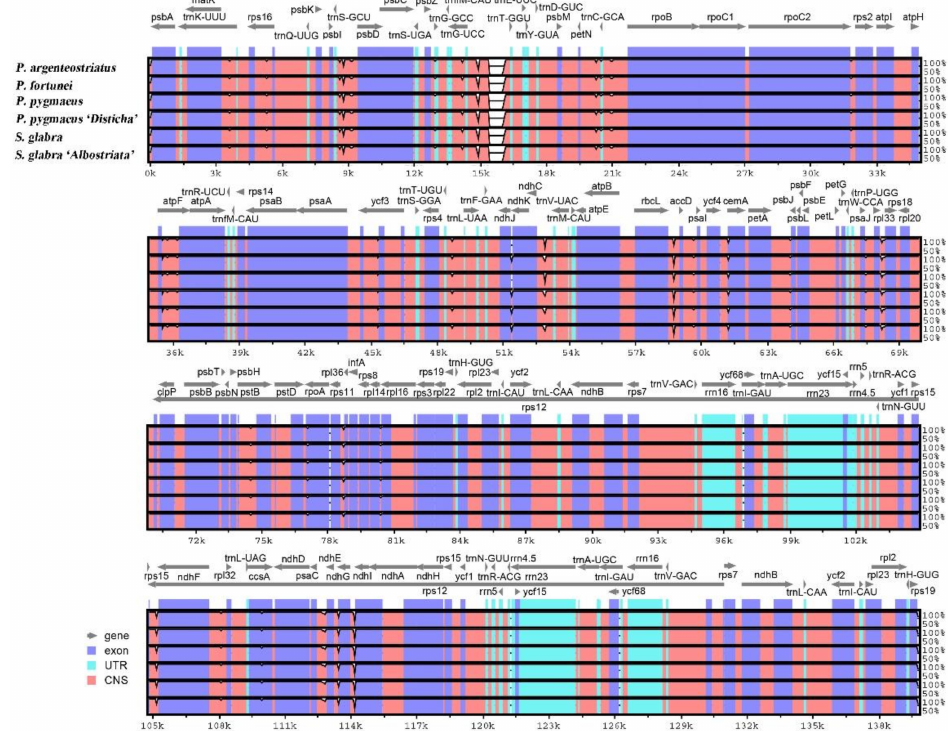
Figure 4. Visualization of the chloroplast genome alignment of seven ornamental bamboo species using S. kongosanensis ‘Aureostriatus’ as reference genome by mVISTA. The x -axis represents the coordinate of the genes in the chloroplast genome. The aligned regions’ sequence similarity is represented by horizontal bars that display the average percent identity within 50 or